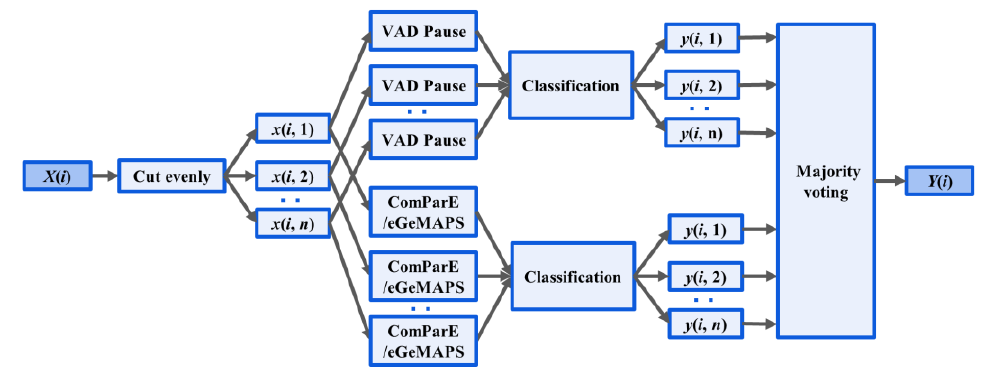
Figure 3. Ensemble Method: X ( i ), the audio recording, was divided into n segments x ( i, n ). Acoustic feature extraction (VAD Pause, ComParE and eGeMAPS) was performed at the segment level. The output of classification for the nth segment of the ith recording is denoted y ( i, n ). Y ( i ) outputs the majority voting for classification.